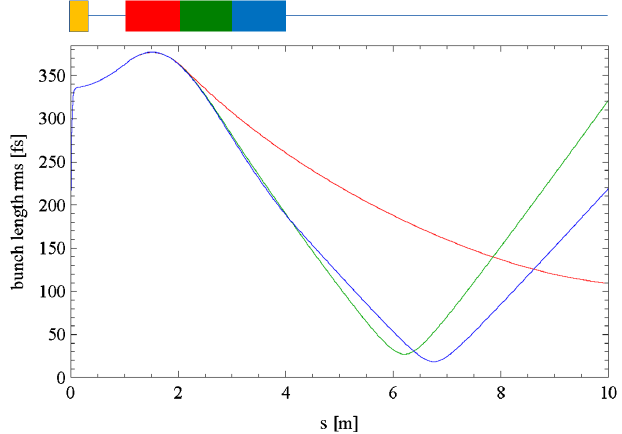
FIG. 4. Velocity bunching as a function of distance (s) from the cathode with a 7 . 5 MV = m buncher cavity of length 1 (red line), 2 (green line), and 3 m (blue